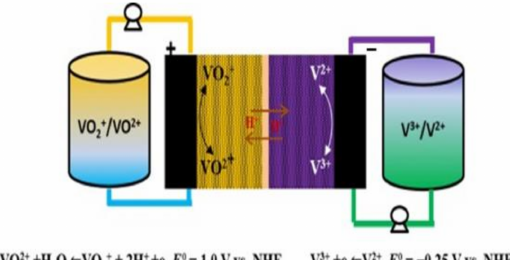
Figure 1. Schematic of vanadium redox flow